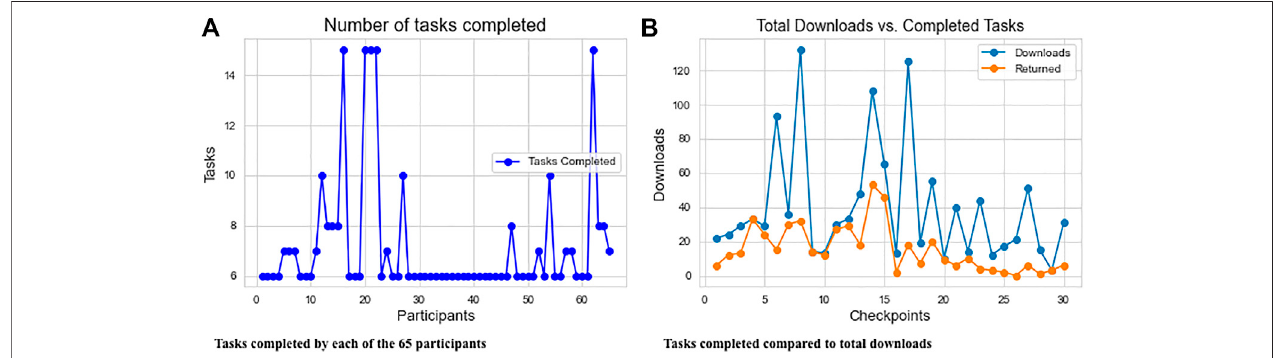
FIGURE 7 | Number of tasks completed by participants compared to total